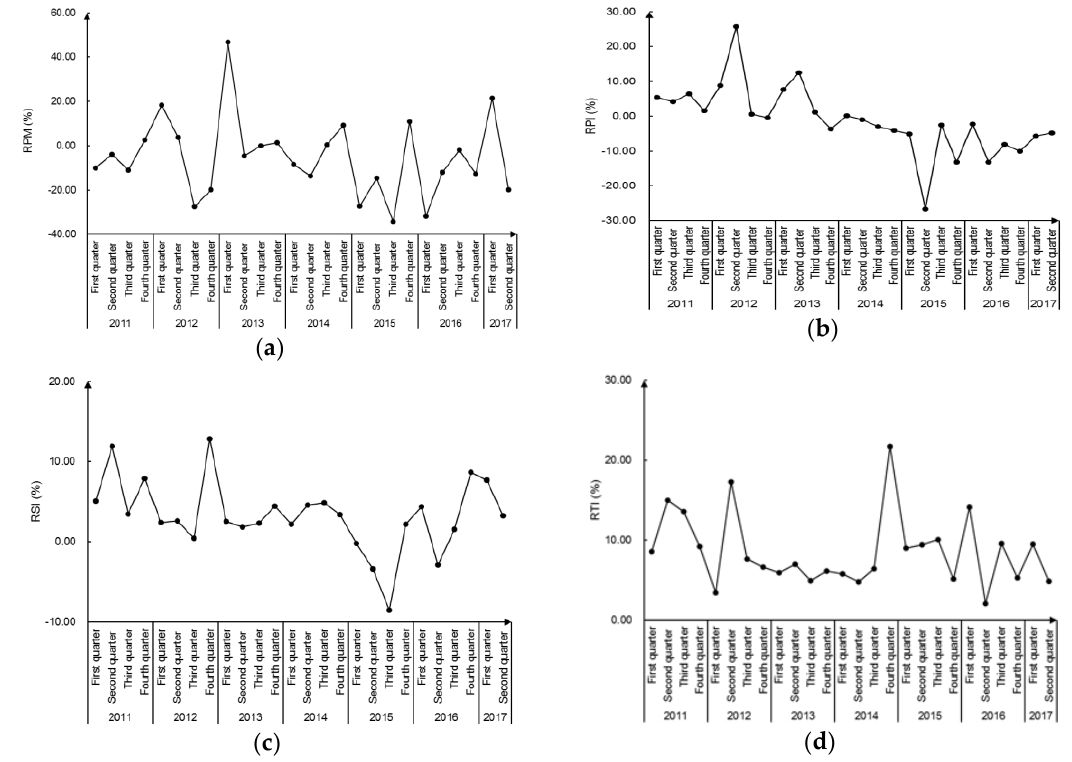
Figure 4. Time series of the variables. ( a ) Changes in the yearly growth rate of PM 2.5 concentration. ( b ) Changes in the yearly growth rate of the primary industry GDP. ( c ) Changes in the yearly growth rate of the secondary industry GDP. ( d ) Changes in the yearly growth rate of the tertiary industry GDP.